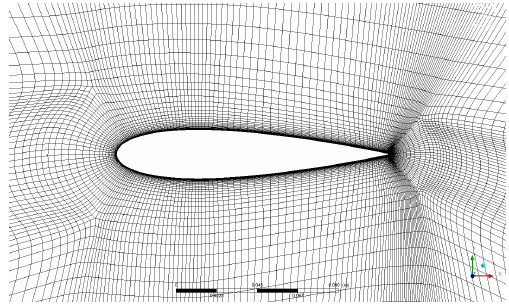
Figure 4. Mesh in the vicinity of the